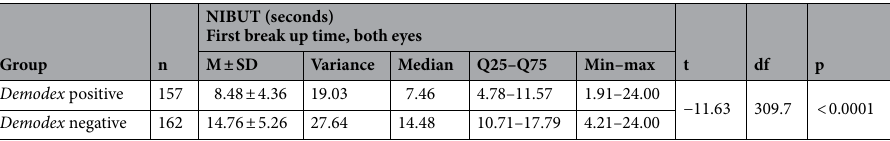
Table 4. Descriptive statistics of the first break up time in both eyes in patients with and without Demodex infestation and results of the t-test with Cochran–Cox correction. Arithmetic mean (M), standard deviation (SD), interquantile range (Q25–Q75), degrees of freedom (df), t-value (t), p-value (p).